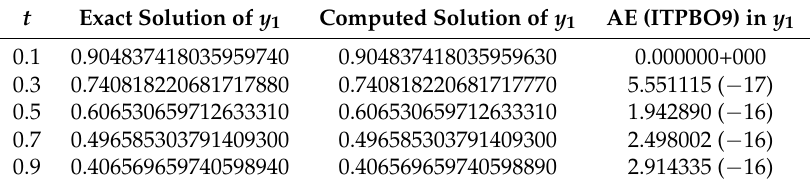
Table 6. Numerical findings for solving y 1 of Problem 4, h = 0.01, t ∈ [ 0,1 ] .